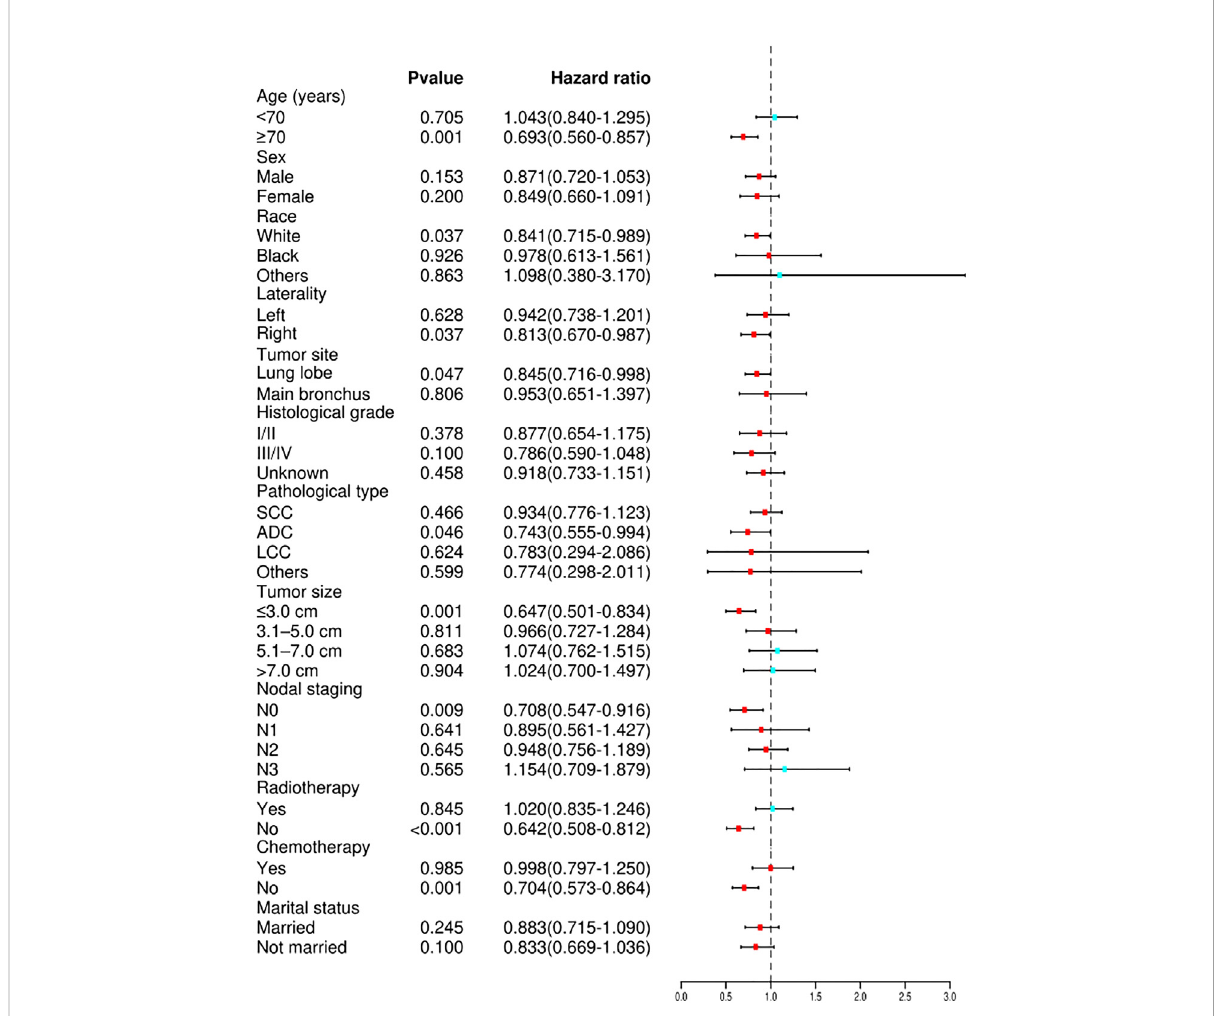
FIGURE 4 Forest plot depicting subgroup analysis of the OS between the TA and non-ablation groups after PSM. SCC, squamous cell carcinoma; ADC, adenocarcinoma; LCC, large cell carcinoma; OS, overall survival; TA, thermal ablation; PSM, propensity score